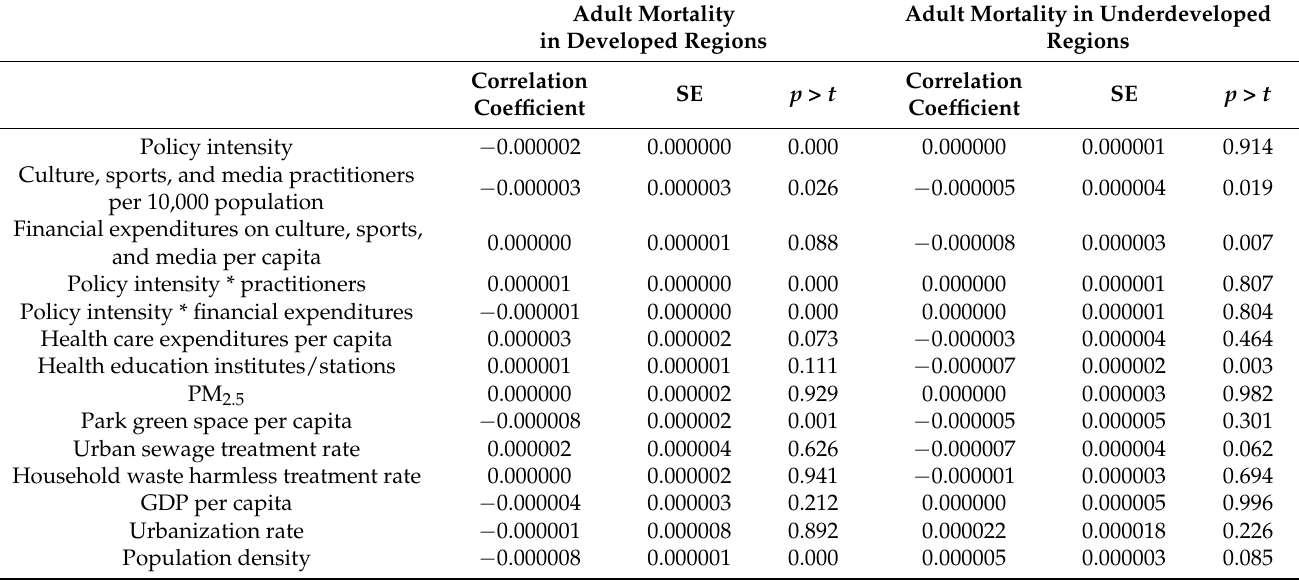
Table 5. Regression results of equation. Adult Mortality in Developed